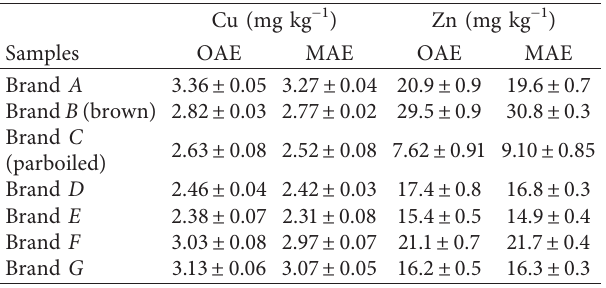
Results are expressed as mean ± standard deviation ( n � 3), dry